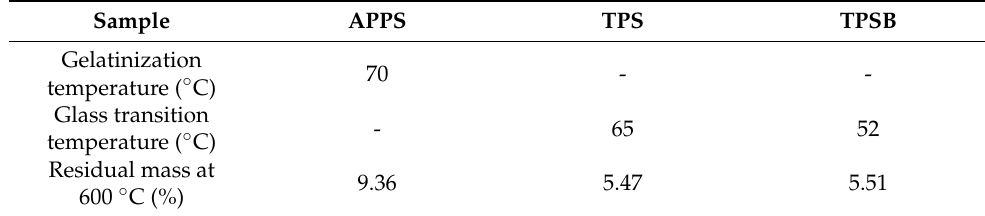
Figure 7. DSC curve and glass trasnsition temperature of APPS, TPS and TPSB. Table 1. Thermal properties of APPS, TPS and TPSB. Table 1. Thermal properties of APPS, TPS and